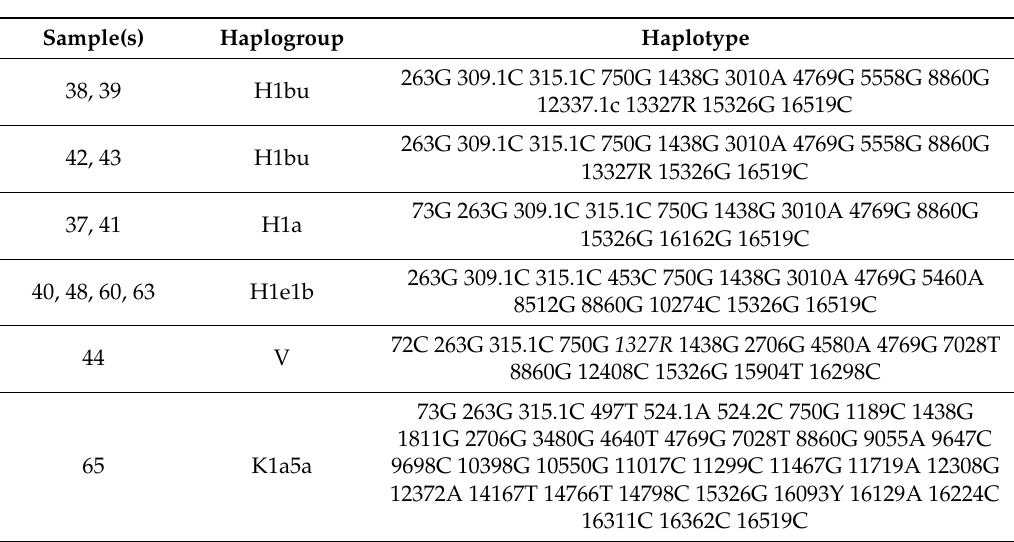
Table 2. The six mitogenome haplotypes observed amongst the 12 successfully sequenced skeletal samples. Corresponding haplogroups are indicated. Length heteroplasmy is indicated by “.1” with a lower case letter designating the inserted base (e.g., 12337.1c). Insertions are indicated by “.1” with a capital letter designating the inserted base.